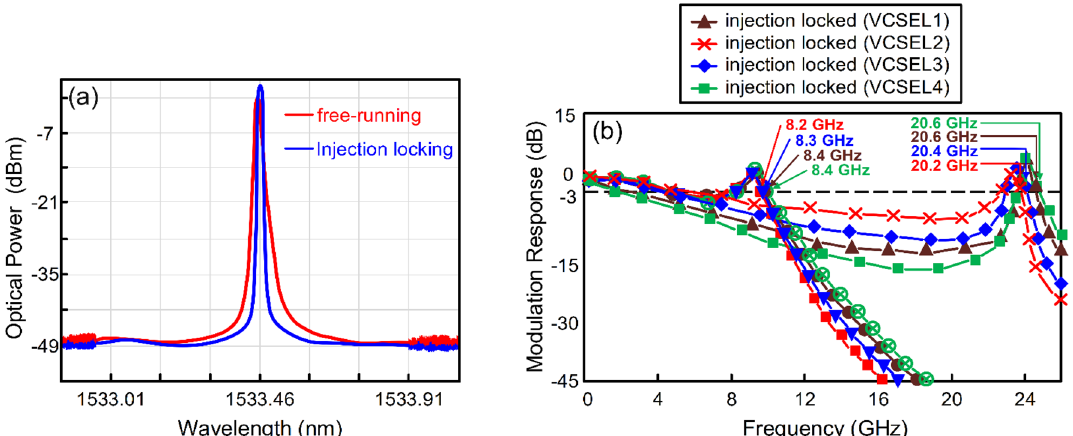
Figure 1. ( a ) The optical spectra of VCSEL1 in free-running and injection-locked states with 56 Gbit/s PAM4 data signal. ( b ) The modulation responses of VCSELs in free-running and injection-locked scenarios with 56 Gbit/s PAM4 data signal.